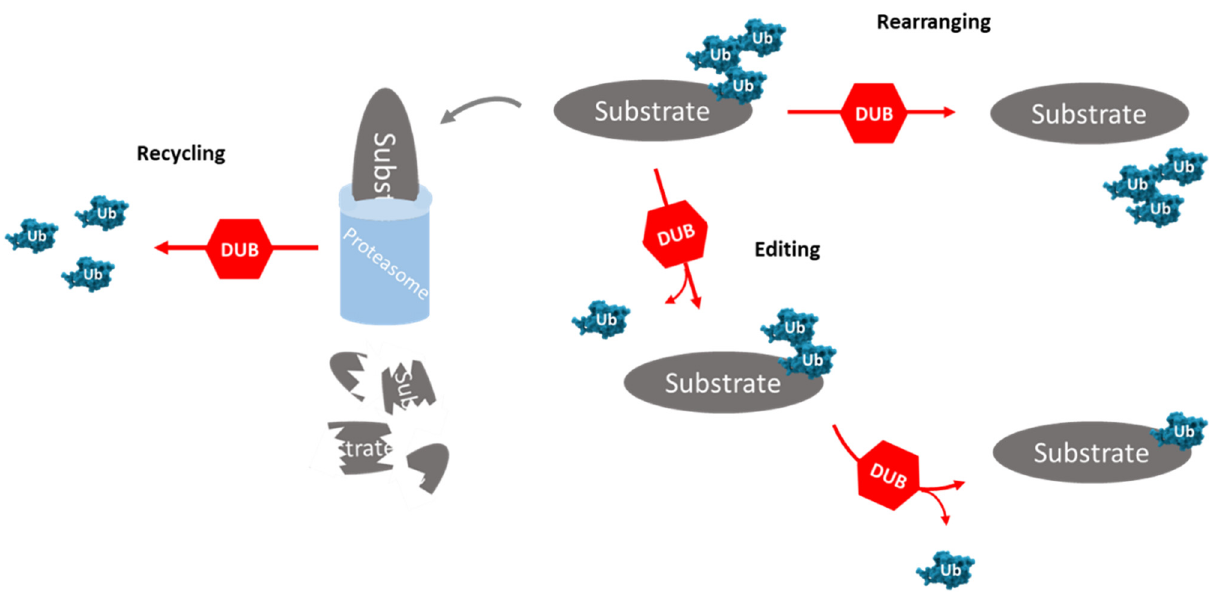
Figure 2. Role of deubiquitinating enzymes (DUBs) in ubiquitin–ubiquitin and ubiquitin–substrate linkages. DUBs can cleave the ubiquitin–substrate bond, rendering the substrate free of ubiquitins (rearranging), modifying the structure of the polyubiquitin chain by removing ubiquitin–ubiquitin linkages (editing) and recycling the ubiquitin associated with proteasomal degradation. DUB: deubiquitinating enzymes; Subs: substrate proteins; Ub: ubiquitin molecules.